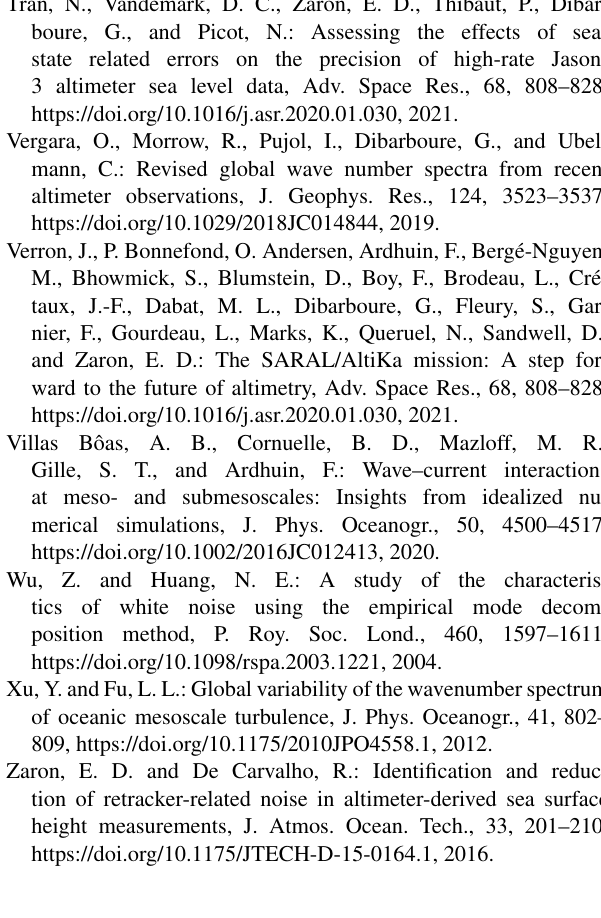
Taburet, N. and SL-TAC team: QUID for Sea Level TAC